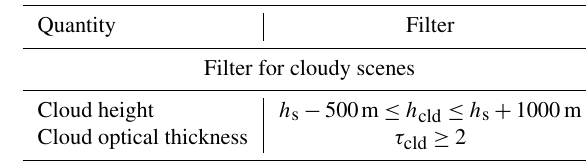
Table 4. Filter criteria for cloudy-sky scenes at high-altitude sta- tions. Here h s denotes the height of the ground